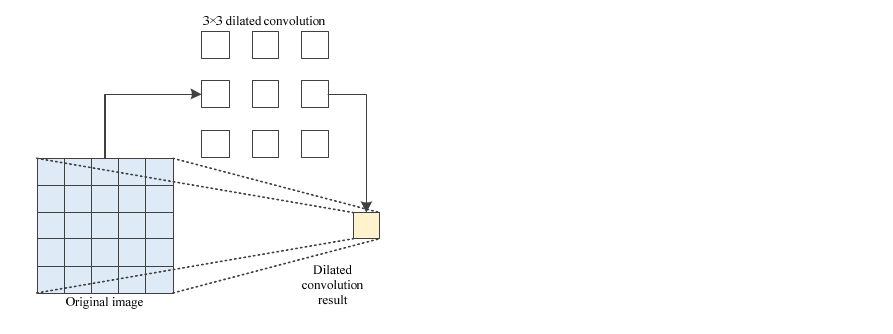
Figure 7. Process of 3 × 3 dilated convolution with the expansion factor of 2.